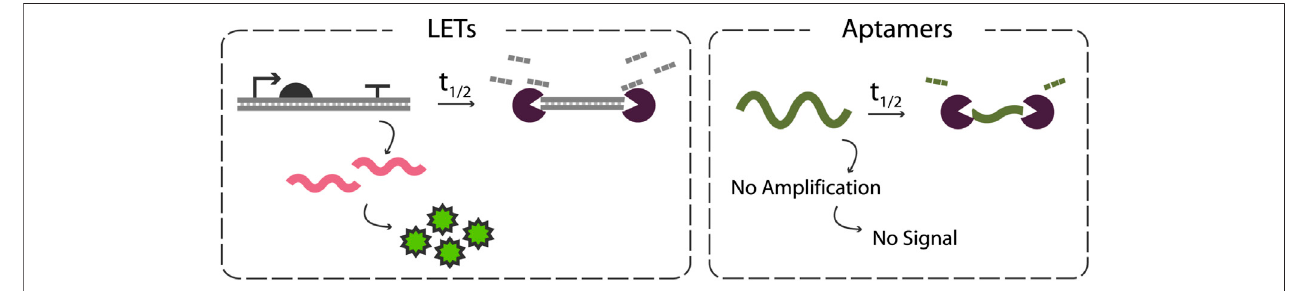
FIGURE3| ComparisonoftheimpactsofdegradationonLETsvsDNAaptamersinCFEs.LETsbene fi tfromdownstreamampli fi cationsteps,leadingtocontinued protein synthesis even after complete LET degradation. Aptamers, however, must be present and intact to execute their function as they do not serve as templates for ampli fi